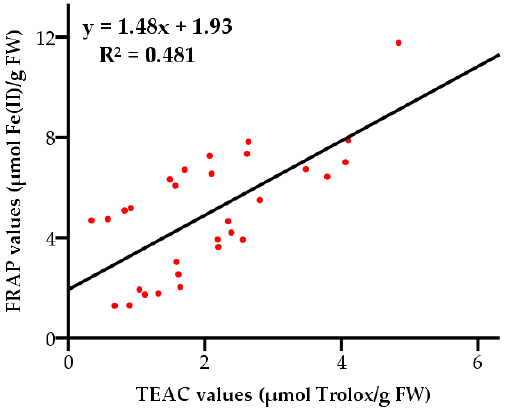
Figure 3. Correlation between total antioxidant activities measured by the FRAP and TEAC assays.